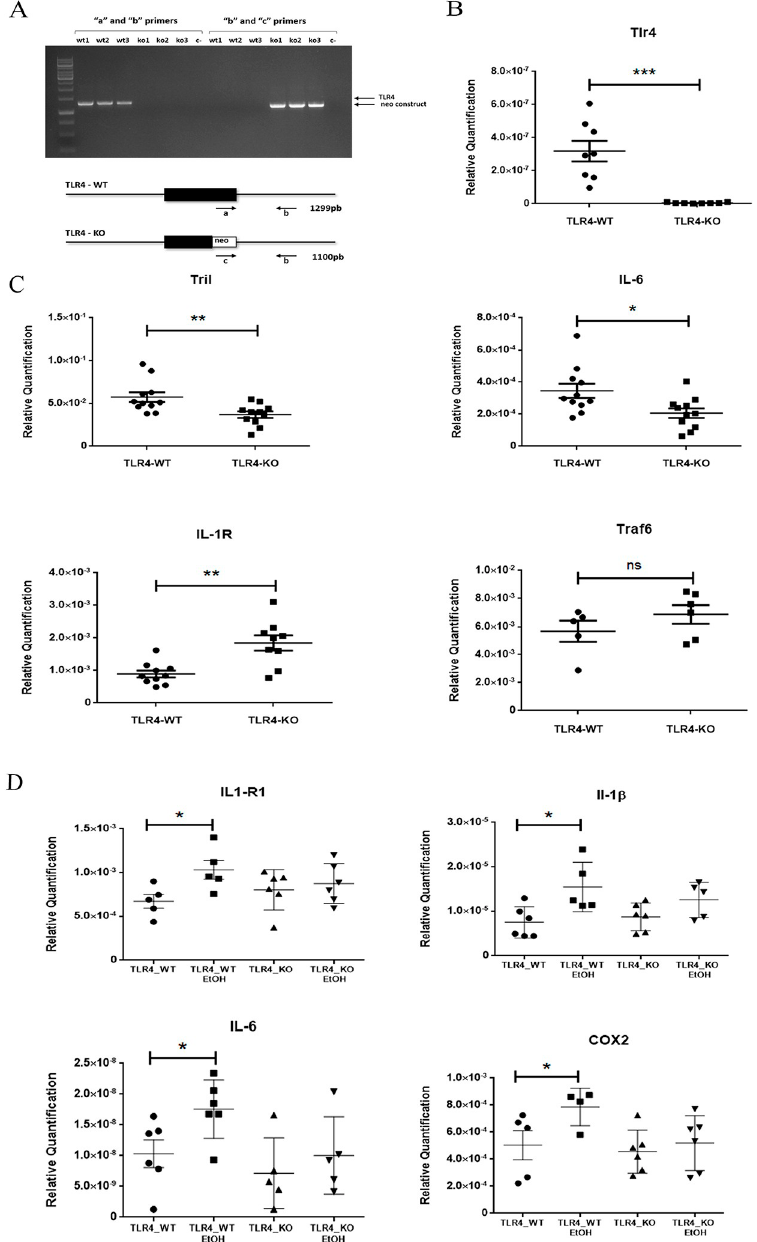
Fig 1. Lack of TLR4 alters the ethanol-induced immune response in mice cortices. ( A ) The genotyping analysis of the wild-type (WT) and TLR4KO mice with specific primers for the locus of the TLR4 receptor were confirmed by agarose gel. ( B) The RT-qPCR analysis in the WT and TLR4-KO mice cortices showed lack of TLR4 gene expression in the TLR4-KO mice. ( C ) The RT-qPCR analysis indicated the deregulation of some TLR4 pathway components, such as Il-6, Tril and IL1R, but not in others like the Traf6 gene. ( D ) The RT-qPCR analysis of IL1R1, IL1 β IL6 and COX2 confirmed that ethanol treatment triggered the activation of specific TLR4 signaling pathway components in the WT mice cortices, but ethanol treatment effects were blocked or attenuated in the TLR4-KO mice. A statistical analysis was performed by the t-test for 1B and-1C and a two-way ANOVA for 1D. Asterisk indicates the significance with a p- value � < 0.05, �� < 0.01 and �� < 0.001. n = 5–10.